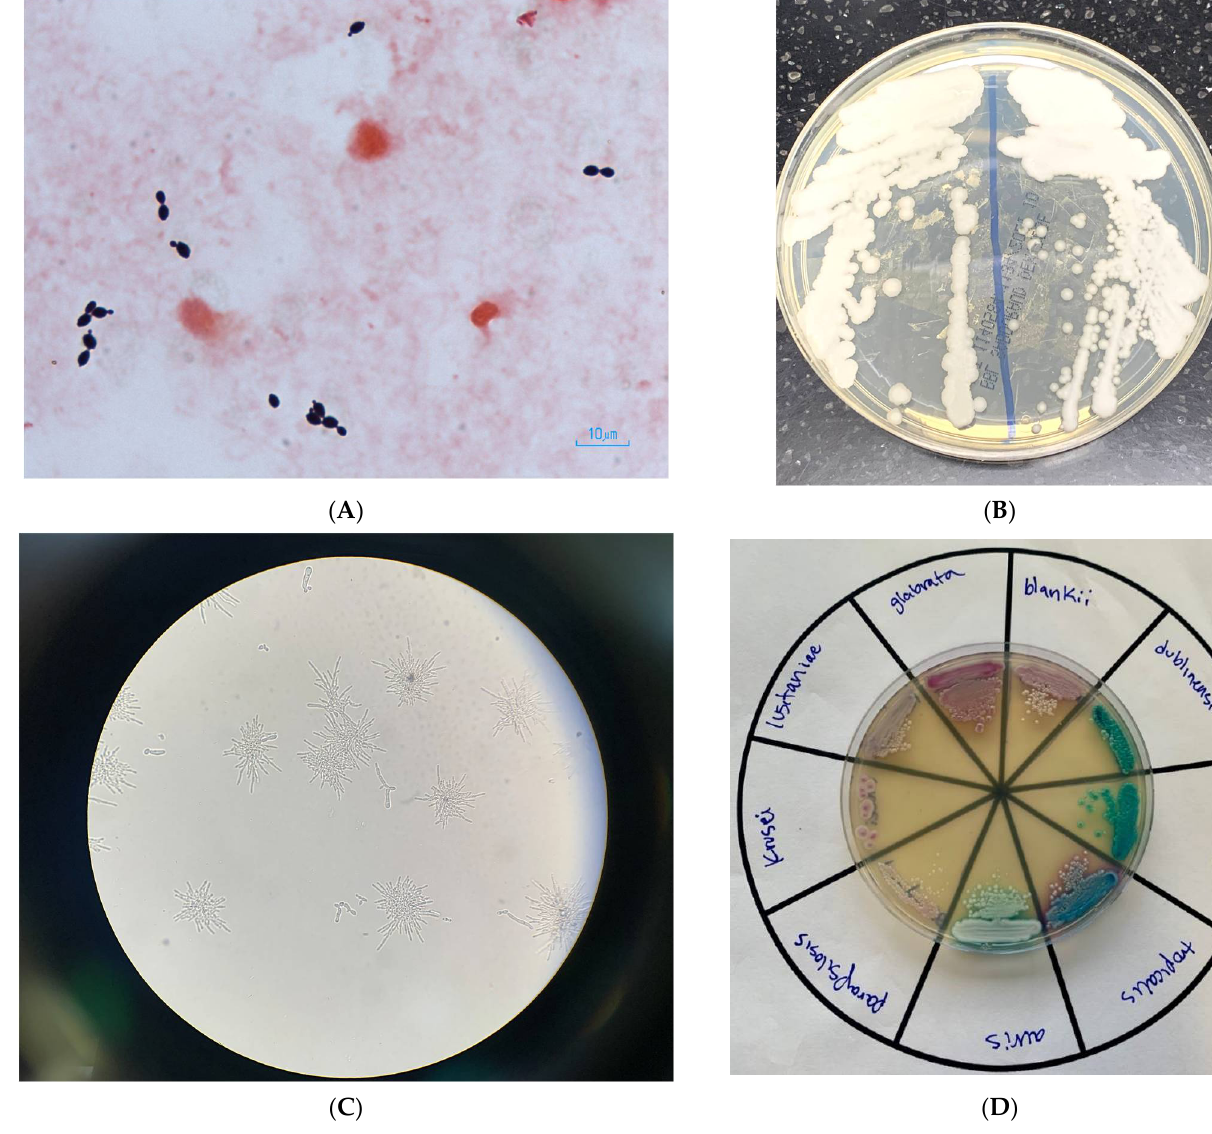
Figure 1. ( A ) Gram stain of blood culture containing yeast, eventually identified as C. blankii ; ( B ) C. blankii growth on a Sabouraud-dextrose agar plate; ( C ) C. blankii pseudohyphae cultured on cornmeal agar with a polysorbate-80 plate. 100× magnification; ( D ) various Candida species cultured on a CHROMagr Candida plus agar plate that selects for and differentiates common Candida species.